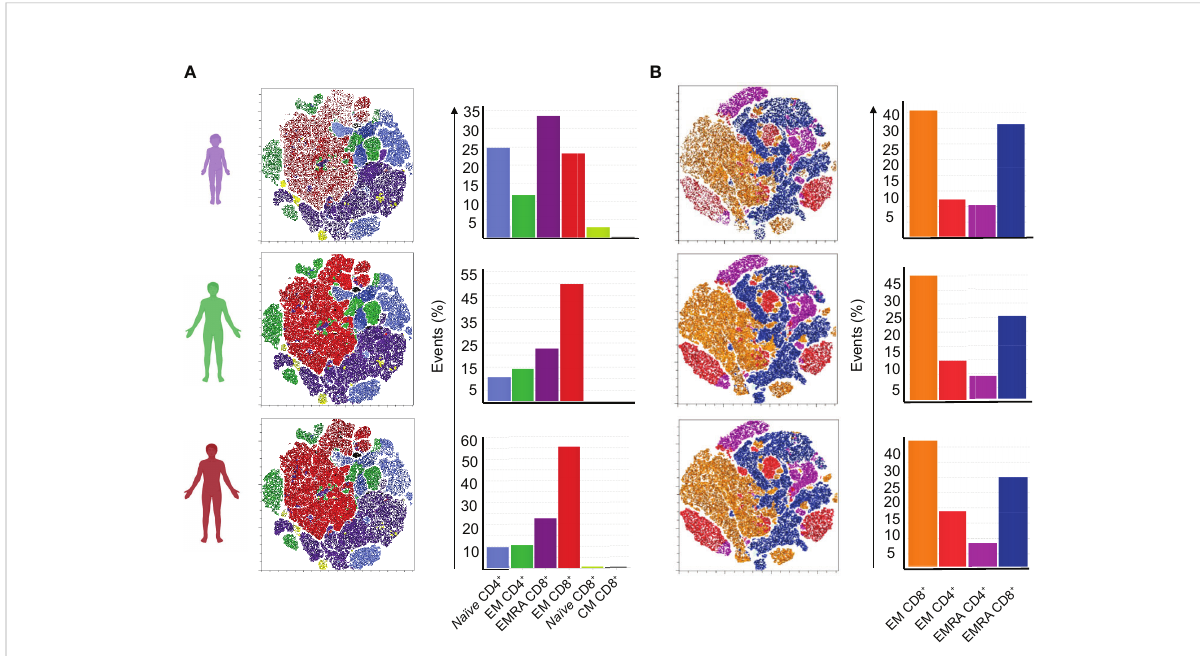
FIGURE 3 Generation dynamics of speci fi c memory T cell responses at 2 nd and 3 rd collection points. An unbiased tSNE analysis was performed for analysis of memory T cells populations, stimulated with peptide pools of the S, N, and M proteins of SARS-CoV-2, gated from live cells. Clusters were characterized by the expression of surface markers CD4, CD8, CD45RA, and CCR7. (A) Clusters at the second time point, from a total of 36 samples (8 children, 17 mild, 11 severe); (B) Clusters at the third time point, from a total of 29 samples (7 children, 12 mild, 10 severe). Bar graphs show frequencies of events in each of the seven most frequent clusters identi fi ed in each time point. Color legends identify clusters as interpreted based on their surface